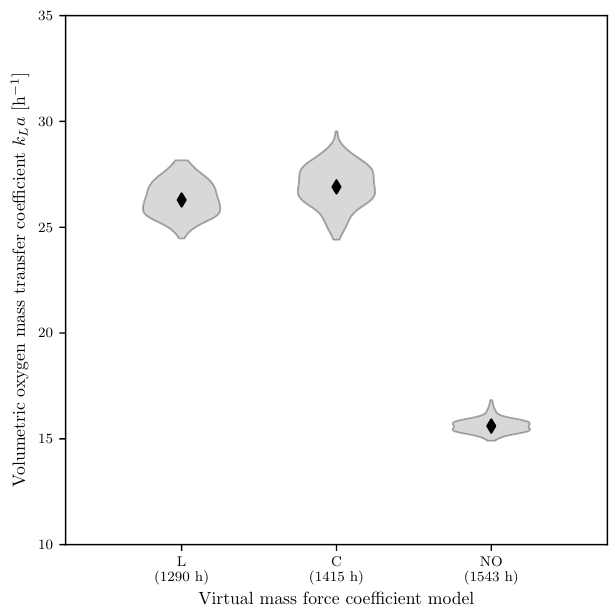
Figure 7. Influence of the virtual mass force coefficient model on the k L a value. The mean values and the corresponding probability density function are shown in violin form. The time corresponds to the CPU time for the simulation of 20 s (L = Lamb [83], C = constant virtual mass coefficient 0.5, NO = no virtual